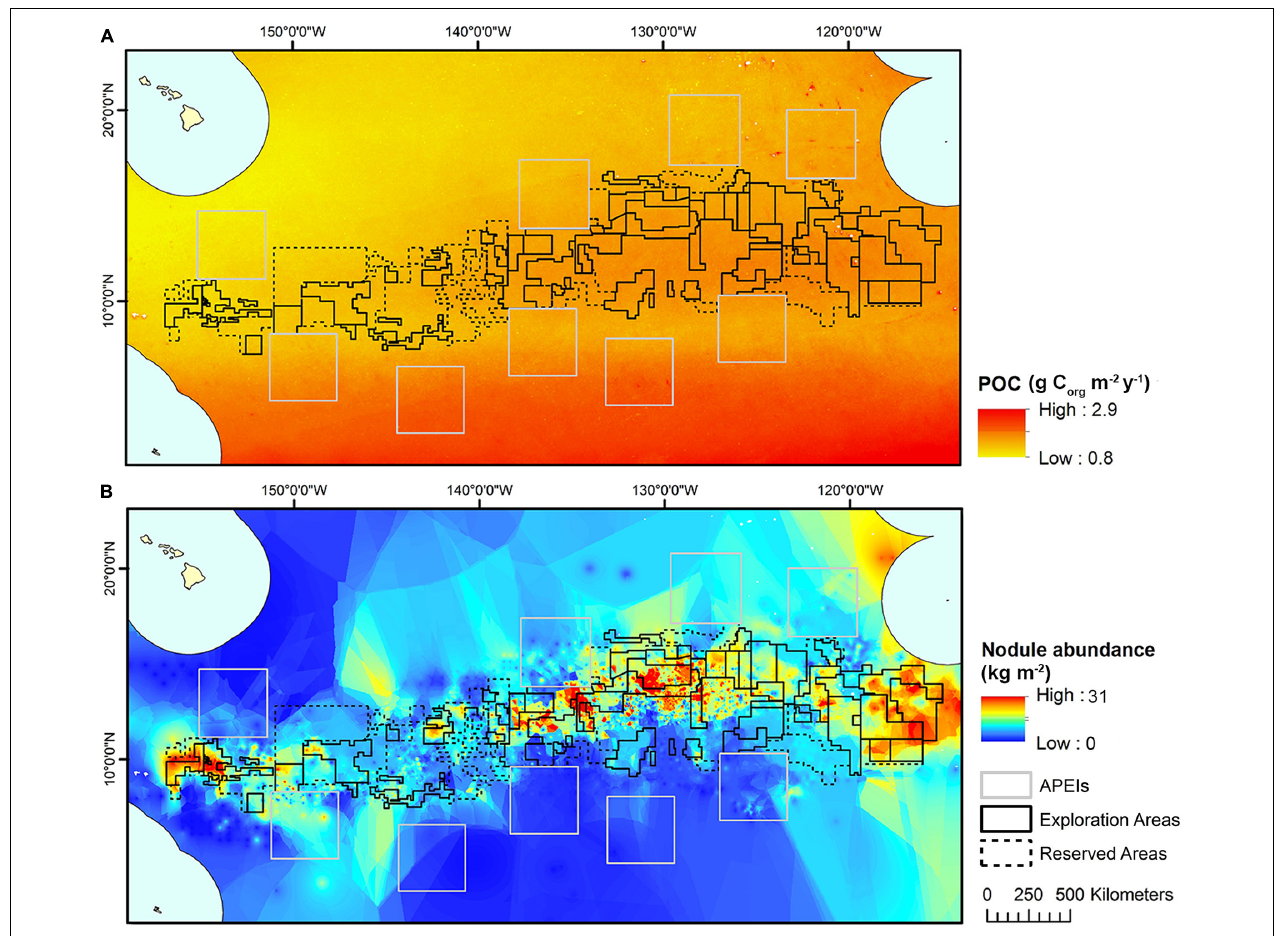
FIGURE 3 | (A) POC flux at the seafloor modeled across the CCZ by Lutz et al. (2007), interpolated to 1 km 2 resolution and used in initial clustering and (B) Nodule abundance modeled across the CCZ (see International Seabed Authority, 2010), interpolated to 1 km 2 resolution and used in initial clustering.